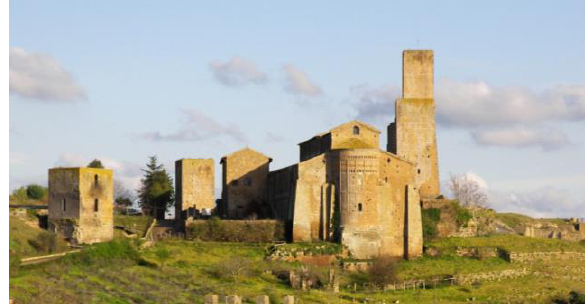
Figure 1. The Basilica of San Pietro.